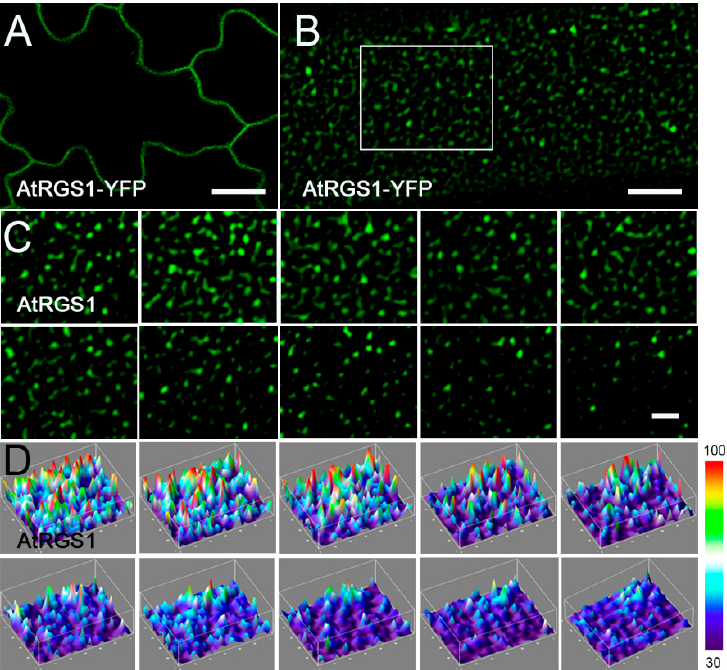
Figure 3. The distribution of AtRGS1 on the PM. ( A ) Confocal images of AtRGS1-YFP in Arabidopsis leaf epidermal cells. Bar = 5 µ m. ( B ) A typical single-particle image for AtRGS1-YFP at the PM. ( C ) Sequential images of the boxed area in ( B ) with a 15 s recording in 1.5 s intervals by VA-TIRFM. Bar = 2 µ m. ( D ) Three-dimensional luminance plots in ( C ) showing varied fluorescence intensity among different spots. Bar = 2 μ m.